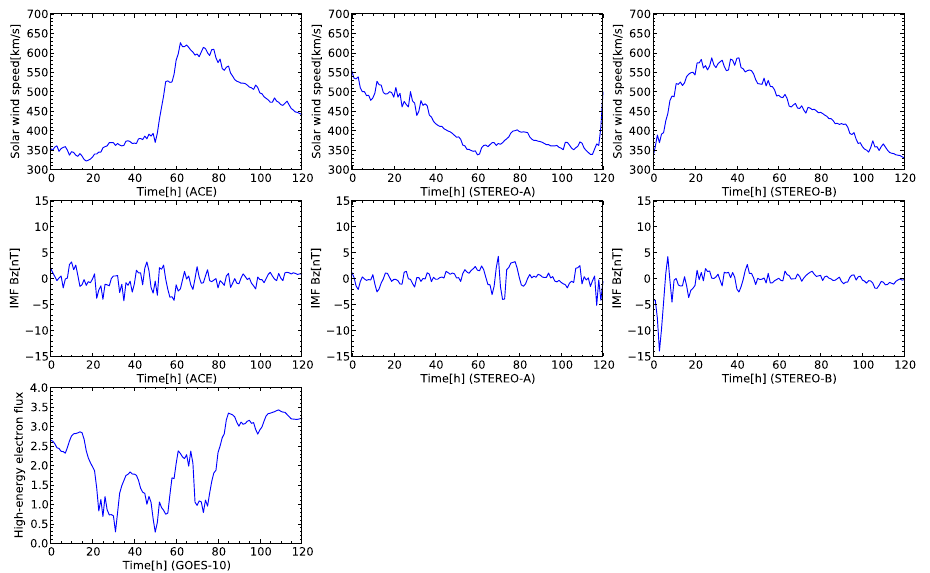
Figure 5. Time development of sensor data for five days from 16 August 2008 at 00:00:00 UTC. This plot contains an event of high-speed solar wind flowing from a coronal hole. In the first and second rows, the plots of the columns correspond to the satellites of ACE, STEREO-A, and STEREO-B, respectively. In the third row, the plot corresponds to